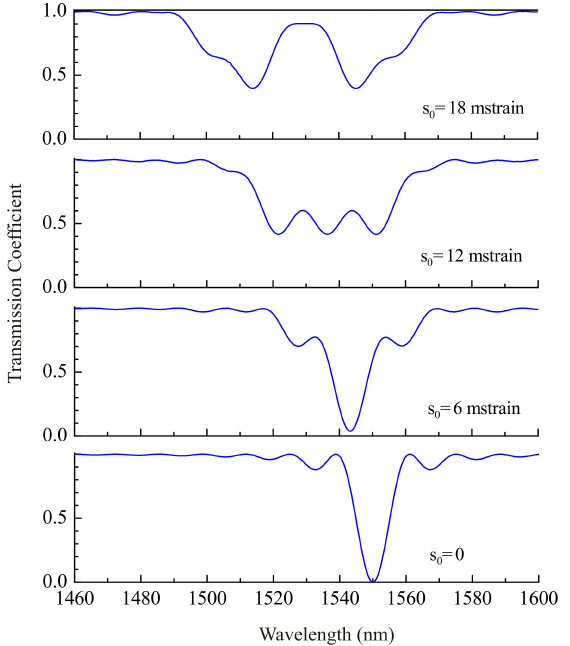
Figure 3. Transmission coefficient of grating for LP 05 cladding mode, when the acoustic front is in its center z 0 = L /2, for different strains s 0 = 0, 6, 12, and 18